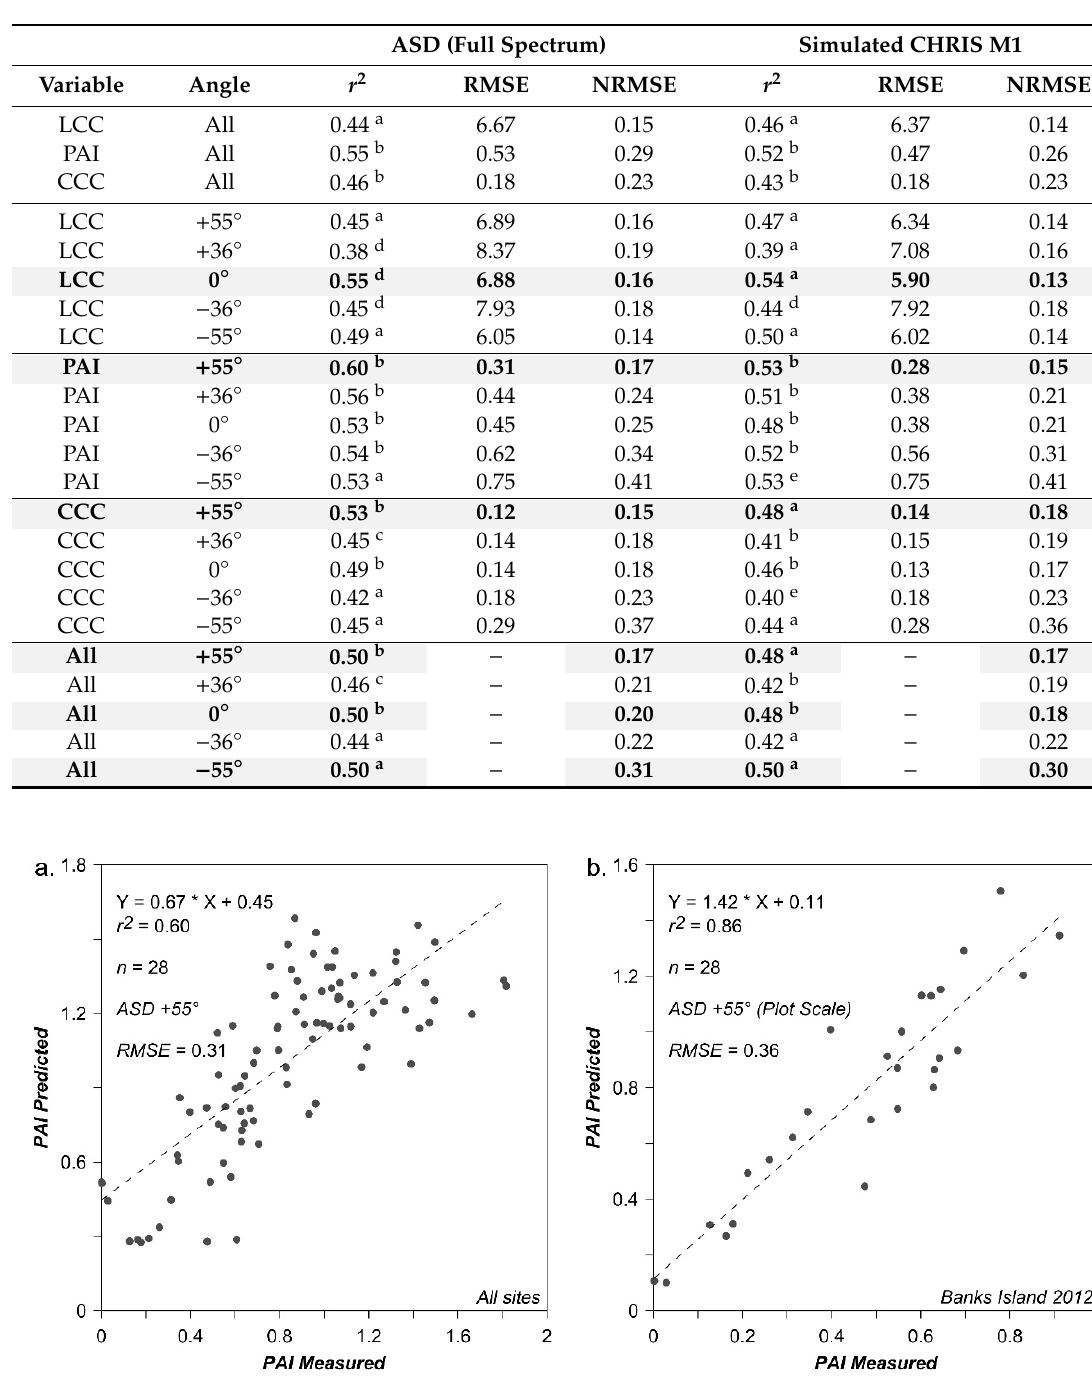
Figure 9. The best LUT inversion predictions for PAI for all sites combined ( a ) and for Banks Island ( b ) for the ASD + 55 dataset. Banks Island produced the best overall model fits compared to other field sites at lower latitudes and to the entire dataset.